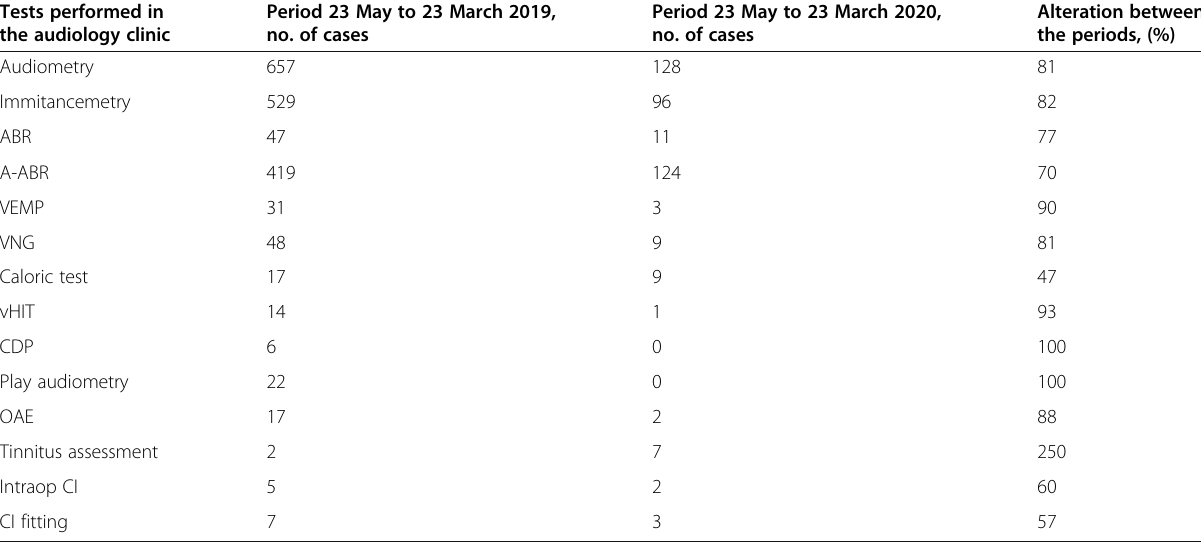
Table 1 The audiology clinic test numbers of 1-year interval during the Covid-19 pandemic Tests performed in Period 23 May to 23 March 2019, the audiology clinic no. of